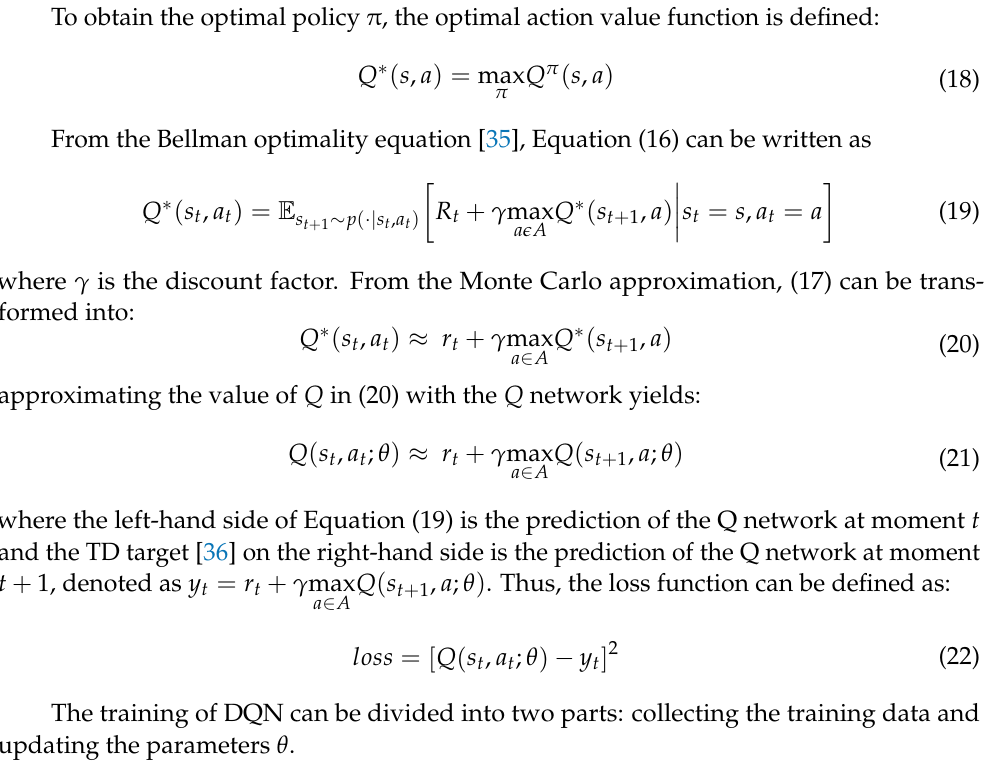
Figure 4. Calculating the Q value for agent